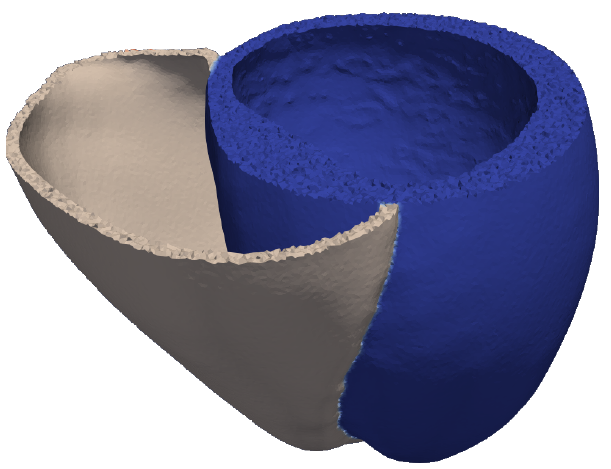
Figure 1. Anatomical model of the left (blue) and right (white) ventricles from the human heart. (The image was generated by the authors from the open data set from file 01.tar.gz which can be found at https://doi.org/10.5281/zenodo.3890034, (accessed on 13 August 2021) in a supplement for paper [16]). There are 405382 points on the image.